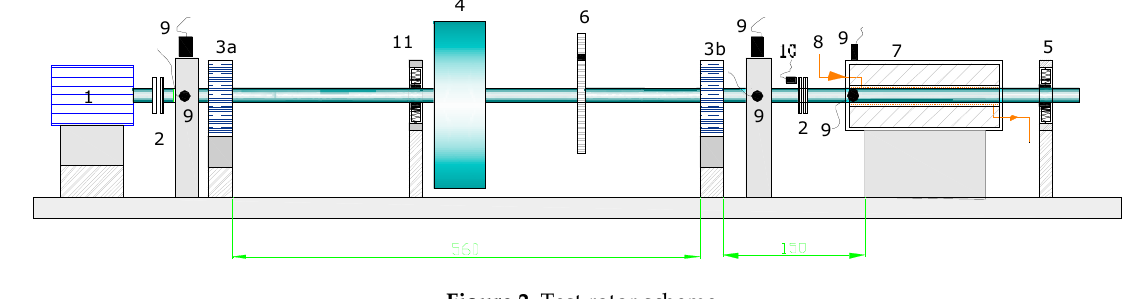
Figure 2. Test rotor